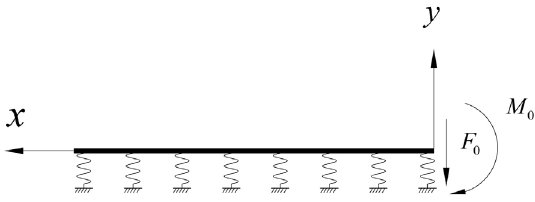
Figure 7. Elastic foundation beam model of foot steel pipe bearing.